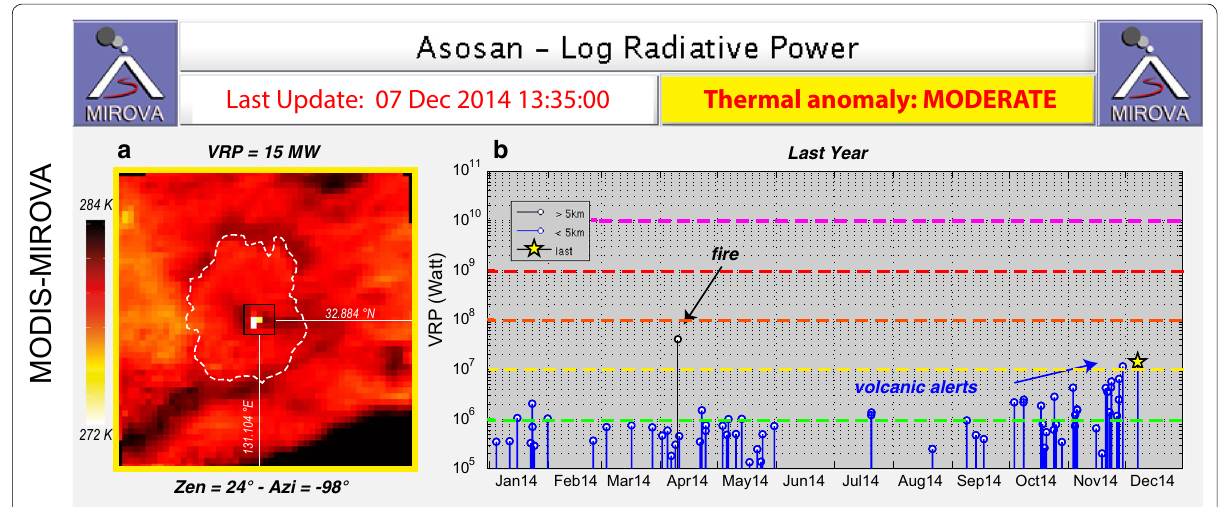
Fig. 3 Example of graphical output, posted automatically on the MIROVA Web site on November 21, 2014. a Last MODIS image (50 50 km) ana- × lyzed by MIROVA. The inner black box (5 5 km) is used to identify distal fires (> 5 km) from summit volcanic activity. b Time series of VRP (log-scale) × recorded during the last month (blue stem). Six thermal levels spanning from 1 MW to 10 GW are reported (see Coppola et al. 2016a for details) with the time series of the last-year thermal record. Note the increasing trend recorded during October–November 2014. The moderate anomaly recorded on April 2014 (black stem) was located at more than 5 km from the summit, and was related to a fire inside the Aso caldera. This kind of plot is continuously updated (http://www.mirovaweb.it/?action volcanoDetails&volcano_id = =